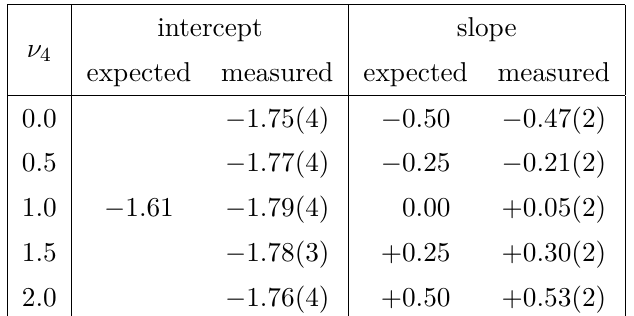
Table 1 . log c 2 vs. log N linear fits for χ -transitions for e between expected and measured values are due to finite-size